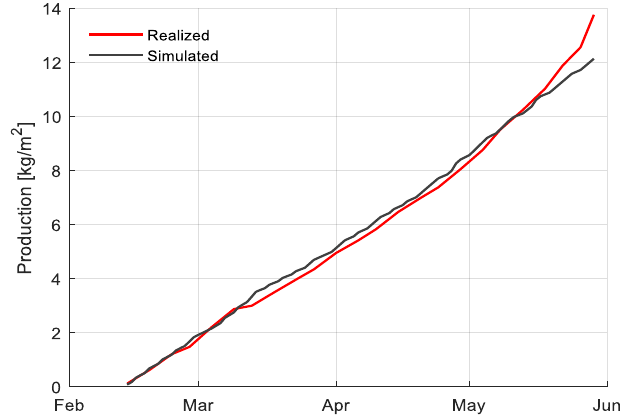
Figure A9. Measured and simulated cumulative fresh weight production (kg / m 2 ) of the after calibration of the models with the actual climate and crop strategies during the experimental period (16